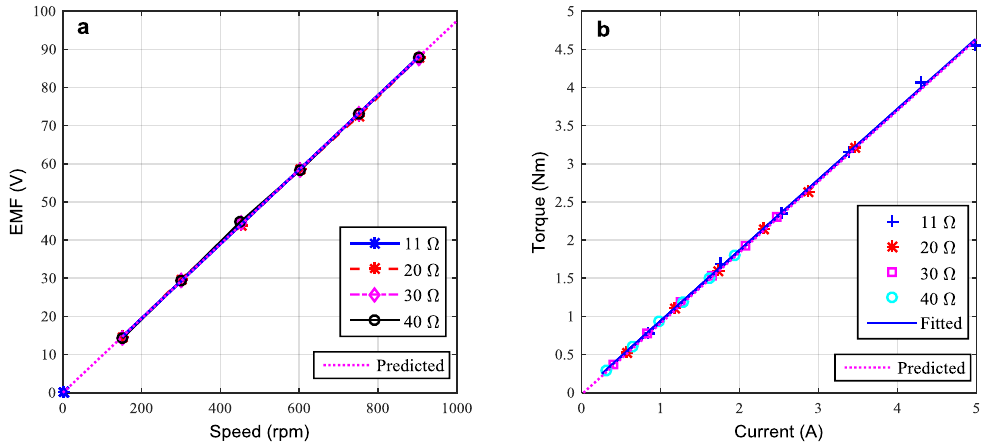
Figure 8. ( a ) Offline fitted voltage constant; ( b ) offline fitted torque constant.